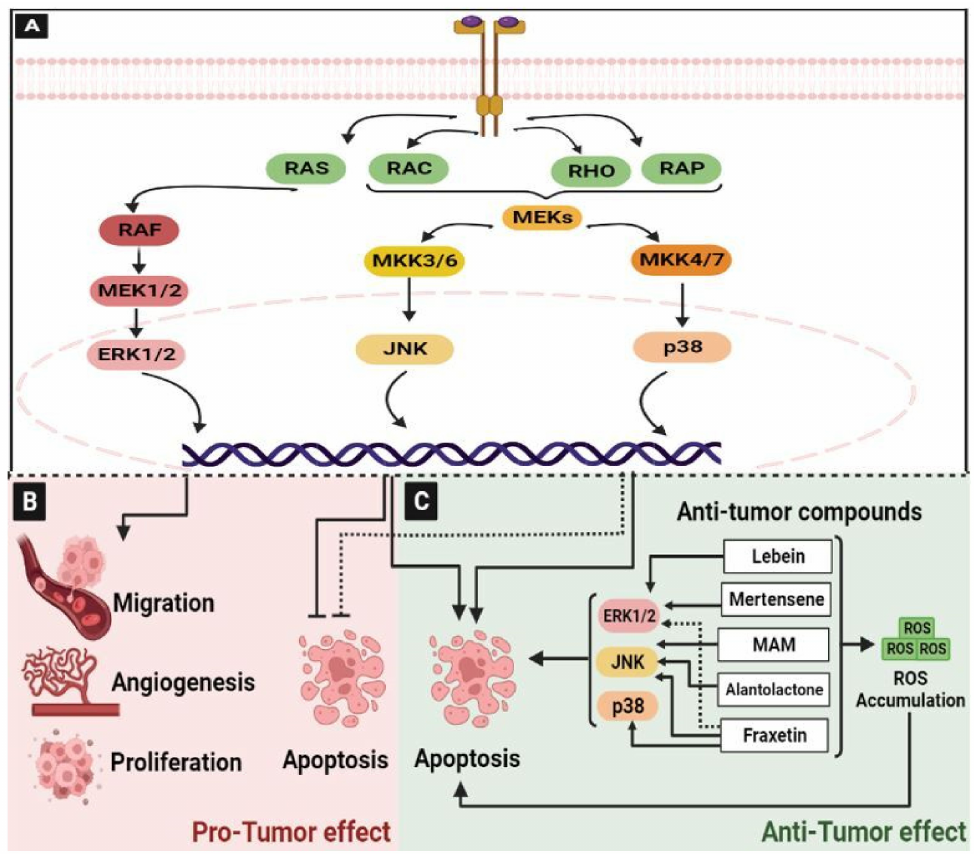
Figure 2. The MAPK signaling pathway in colorectal cancer. ( A ) Schematic representation of acti- vated MAPK pathway: The interaction of mitogens and growth factors with the receptor tyrosine kinase promotes its activation and dimerization. Then, it activates the small GTPases (Ras, Rac, RHO, or RAP) subsequent to the activation of MAPKKK (Raf or MEKs) and MAPKK (MEK1/2, MKK3/6, or MKK6/7). Finally, MAPKK activates ERK1/2, p38, or JNK, and they are translocated to the nucleus to interact and activate many transcription factors, leading to the target genes’ transcription. ( B ) MAPK pathway is involved in many oncogenic processes such as cell migration, angiogenesis, and tumor proliferation. In addition, it can inhibit apoptosis. ( C ) MAPK also exhibited anti-proliferative and pro-apoptotic activities in CRC. Many natural anti-tumor compounds induce tumor cell apoptosis through ERK1/2, JNK, or/and p38. Indeed, Lebein and Mertensene activate ERK1/2, MAM